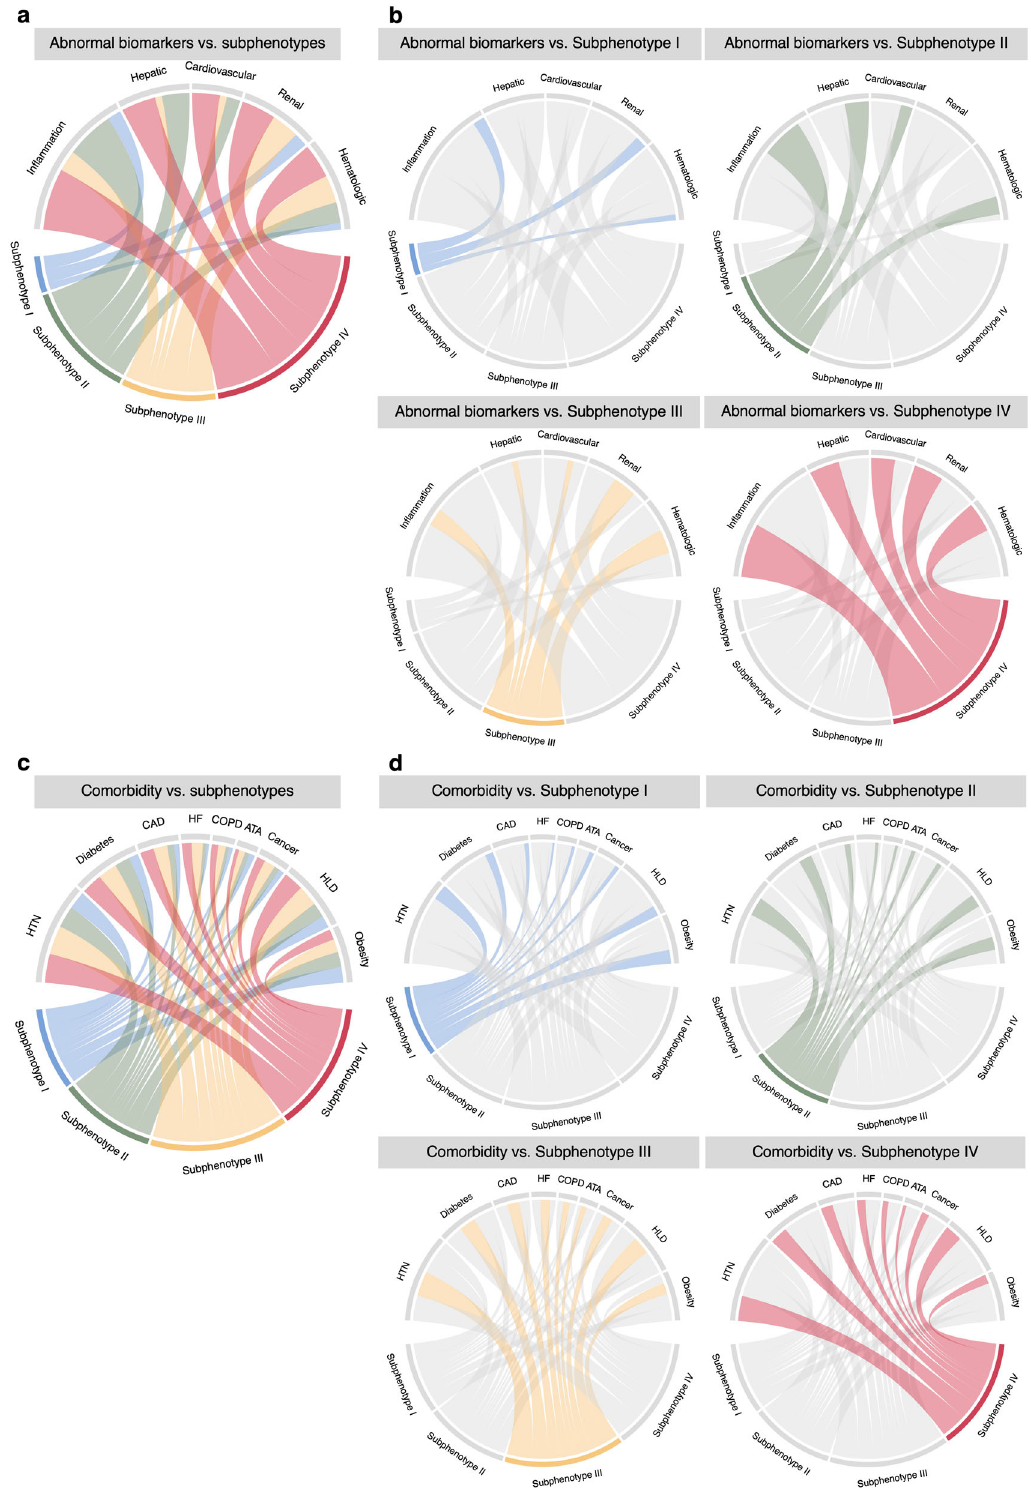
Fig. 2 Chord diagrams showing differences in abnormal clinical variables and comorbidity burden among subphenotypes. a Abnormal biomarkers vs. all subphenotypes. b Abnormal biomarkers vs. each subphenotype. c Comorbidities vs. all subphenotypes. d Comorbidities vs. each subphenotype. ATA asthma, CAD coronary artery disease, COPD chronic obstructive pulmonary disease, HF heart failure, HLD hyperlipidemia, HTN